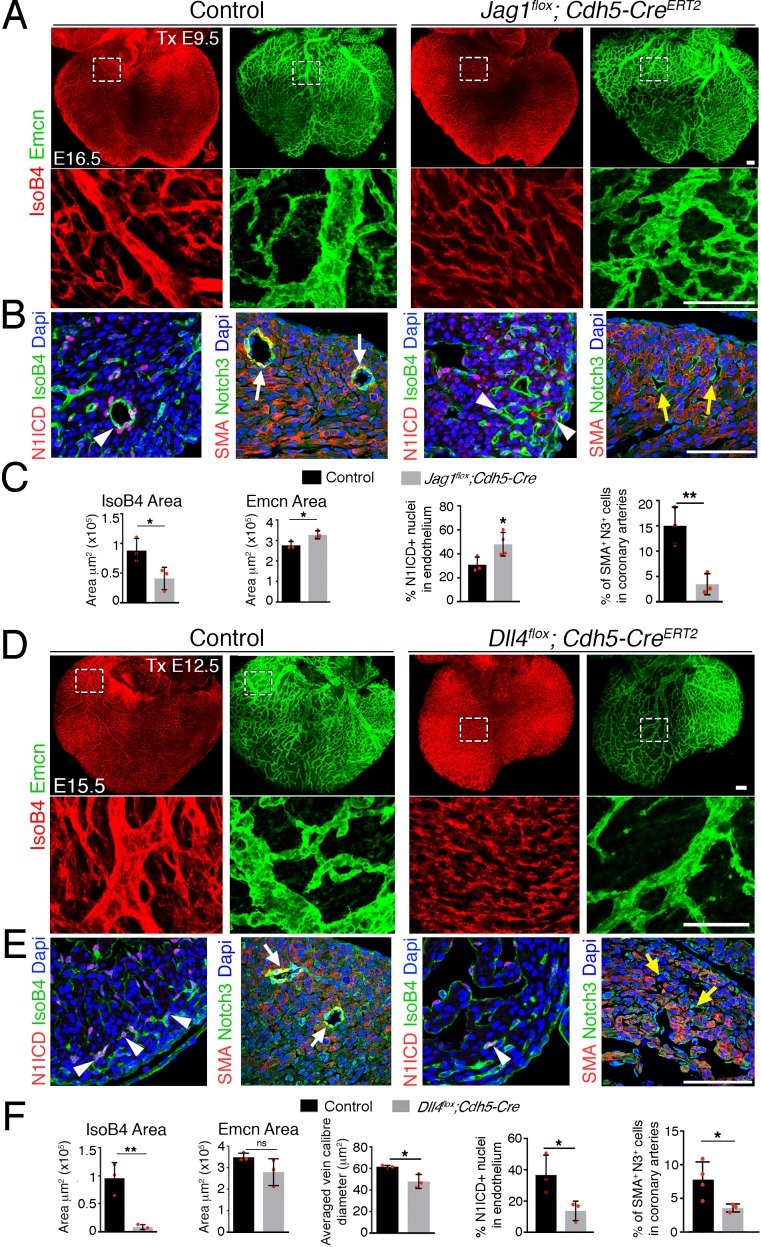
Late endothelial Jag1 or Dll4 inactivation disrupts coronary plexus remodeling.(A) Dorsal view of whole-mount immunochemistry for IsoB4 (red), labeling arteries and Emcn (green), labeling veins and capillaries, in E16.5 control and Jag1flox;Cdh5-CreERT2 mutant hearts, tamoxifen (Tx)-induced at E9.5. Scale bars, 100 μm. (B) E16.5 control and Jag1flox;Cdh5-CreERT2 mutant heart sections. Left, Immunostaining for N1ICD (red) and IsoB4 (green). Right, α-smooth-muscle actin (SMA, red) and Notch3 (green). Dapi counterstain (blue). Arrowheads point to N1ICD-positive nuclei. Arrows point to SMA-Notch3 co- immunostaining. Yellow arrows point to small calibre intramyocardial vessels in Jag1 mutant. (C) Quantified data from E15.5 control and Jag1flox;Cdh5-CreERT2 hearts: area of coverage by coronary arteries (IsoB4-positive vessels) and veins (Emcn-positive vessels). Data are mean ± s.d. (n = 3 control embryos and 3 mutant embryos); N1ICD-positive nuclei as a percentage of total endothelial nuclei Data are mean ± s.d. (n = 3 sections from 3 control embryos and 4 mutant embryos); and SMA-Notch3 co-immunostaining in coronary arteries. Data are mean ± s.d. (n = 3 sections from 3 control embryos and 3 mutant embryos). (D) Whole-mount dorsal view of immunohistochemistry IsoB4 (red), labeling arteries and Emcn (green), labeling veins and capillaries, in E15.5 control and Dll4flox;Cdh5-CreERT2 mutant hearts Tx-induced at E12.5. (E) Immunohistochemistry on the left for N1ICD (red) and IsoB4 (green), and on the right for SMA (red) and Notch3 (green) on control E15.5 WT and Dll4flox;Cdh5-CreERT2 mutant heart sections. Dapi counterstain (blue). Arrowheads indicate N1ICD-positive nuclei. Arrows point to SMA-Notch3 co- immunostaining. Yellow arrows point to small calibre intramyocardial vessels in the Dll4 mutant. Scale bars as in (A). (F) Quantified data from E16.5 control and Dll4flox;Cdh5-CreERT2 hearts: area covered by coronary arteries (IsoB4-positive vessels); area covered by veins (Emcn-positive vessels); mean vein caliber Data are mean ± s.d. (n = 3 control embryos and 3 mutant embryos); percentage of N1ICD-positive nuclei in endothelium as a percentage (%) of total nuclei; and SMA-Notch3 co- immunostaining in coronary arteries. Data are mean ± s.d. (n = 3 sections from 3Control embryos and from 3 to 4 mutant embryos). *p<0.05, **p<0.01, by Student’s t-test; n.s., not significant. Scale bars, 100 μm. Microscope: Nikon A1-R. Software: NIS Elements AR 4.30.02. Build 1053 LO, 64 bits. Objectives: Plan Apo VC 20x/0,75 DIC N2 dry; Plan Fluor 40x/1,3 Oil DIC H N2 Oil.